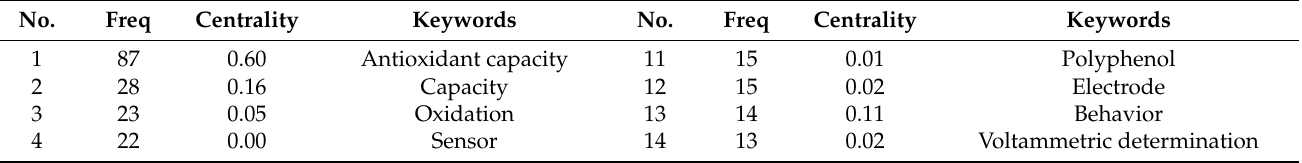
Table 2. List of top 20 keywords for the evaluation of antioxidants using electrochemical